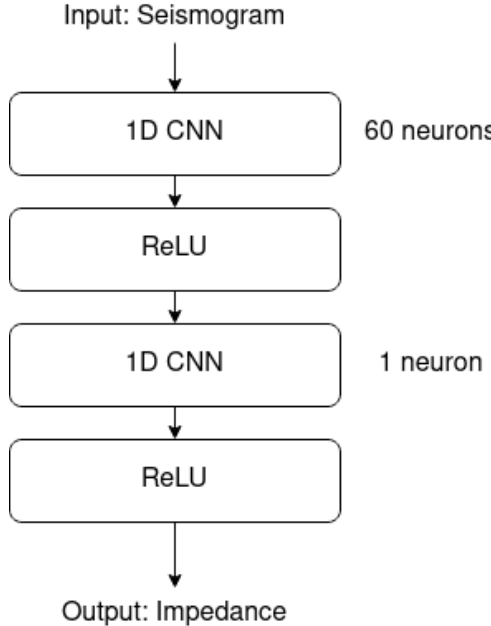
Figure 4. A 1D CNN architecture. Source: adapted from